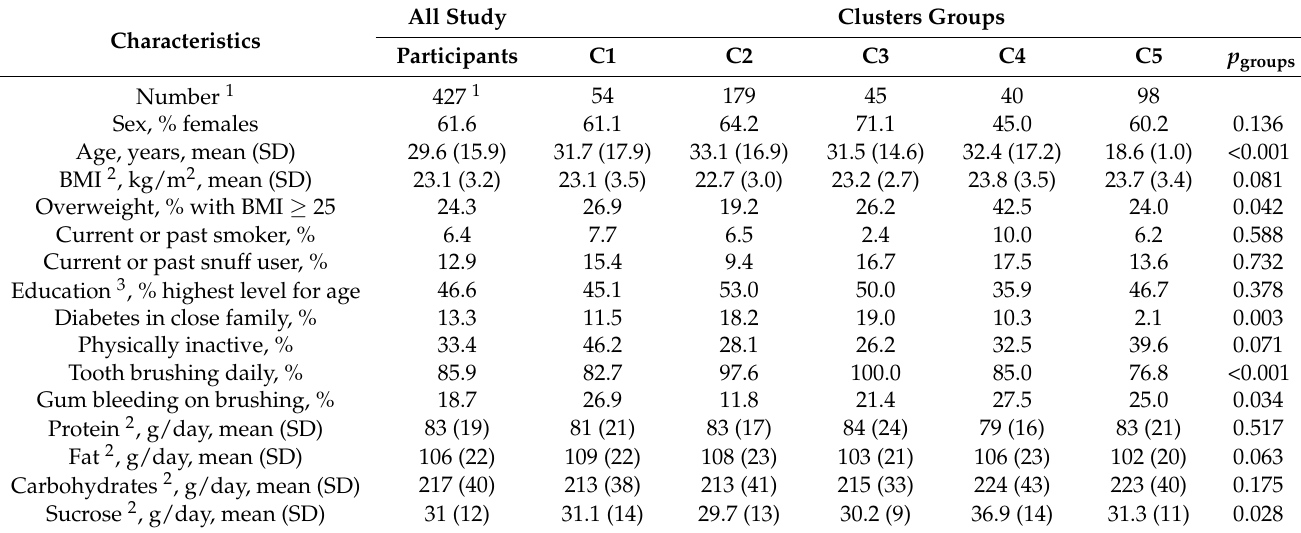
Table 1. Characteristics of the participants in the derivation